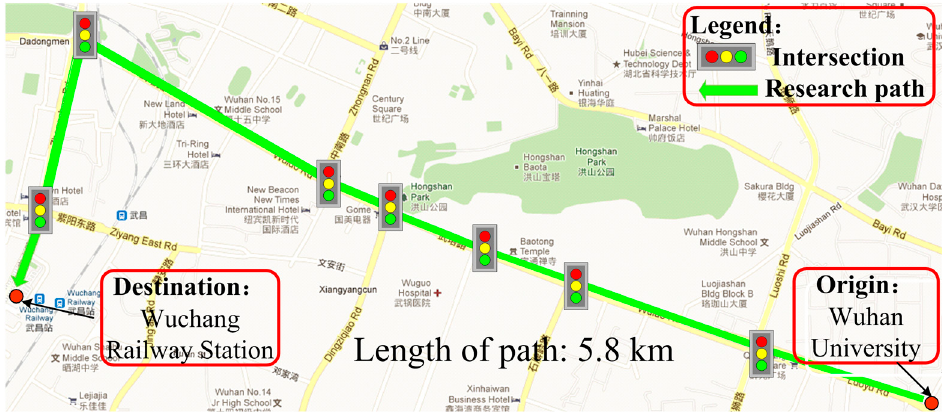
Figure 6. Location of study path in Wuhan, China.